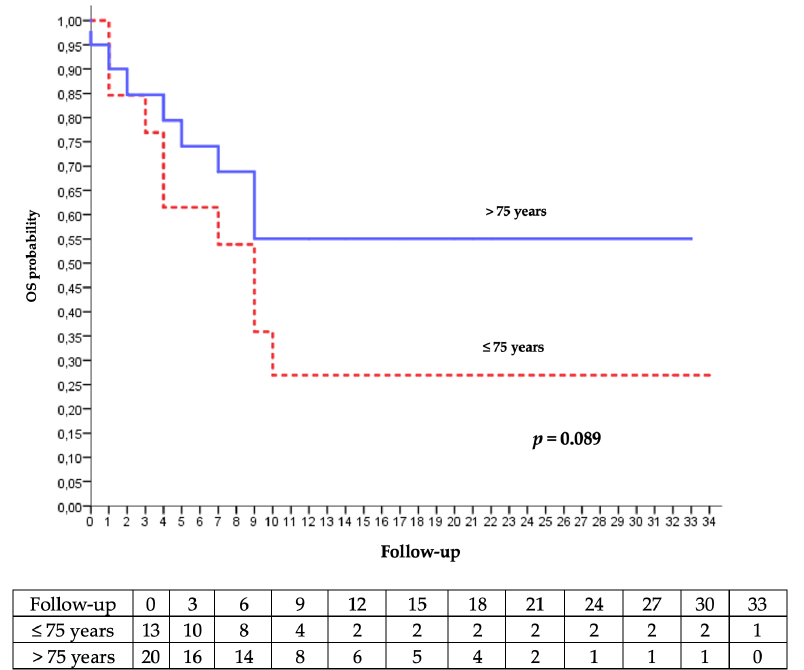
Figure 4. Kaplan–Meier analysis of overall survival according to the number of cemiplimab sessions (<10 vs. ≥ 10).